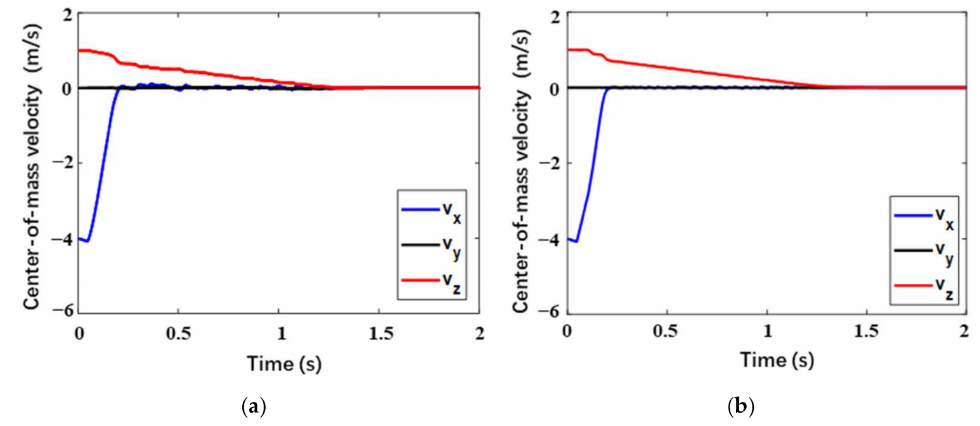
Figure 10. Center-of-mass velocity of lunar lander in Case 1 within ( a ) buckypaper and ( b ) aluminum